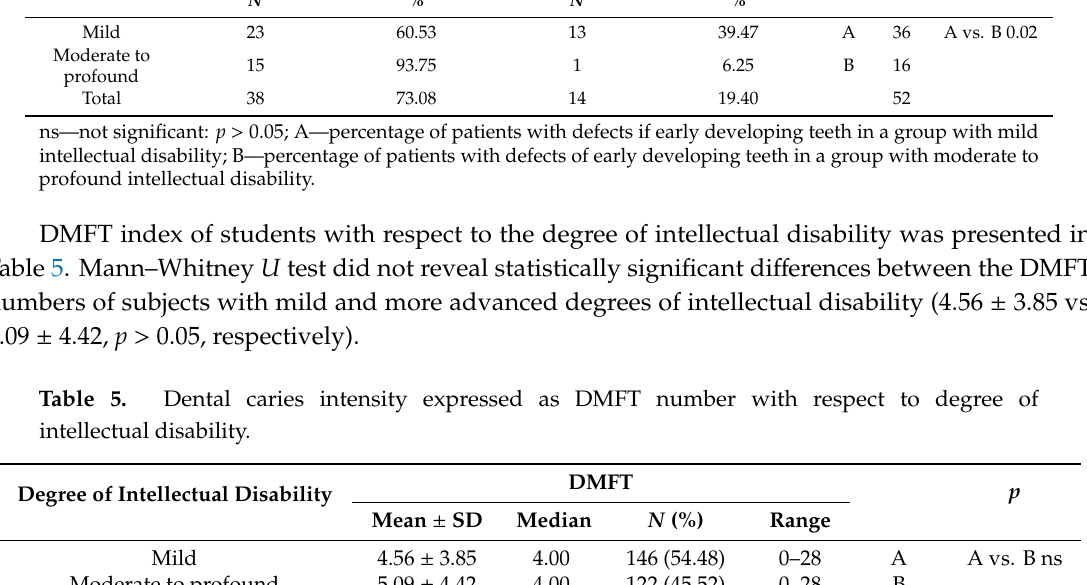
Table 4. Number of special-care students with DDE of early and late developing teeth with respect to degree of their intellectual disability.